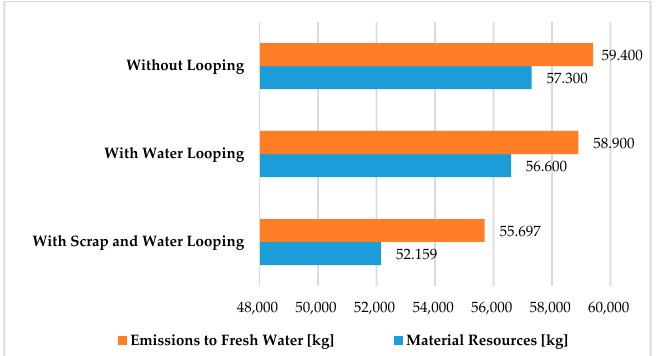
Figure 1. Values of material resources and emissions to fresh water in the production stage for the examined production solutions with transport. (Functional unit: 25 kg polypropylene product. Normalization unit: kilogram, weighting quantity: mass).